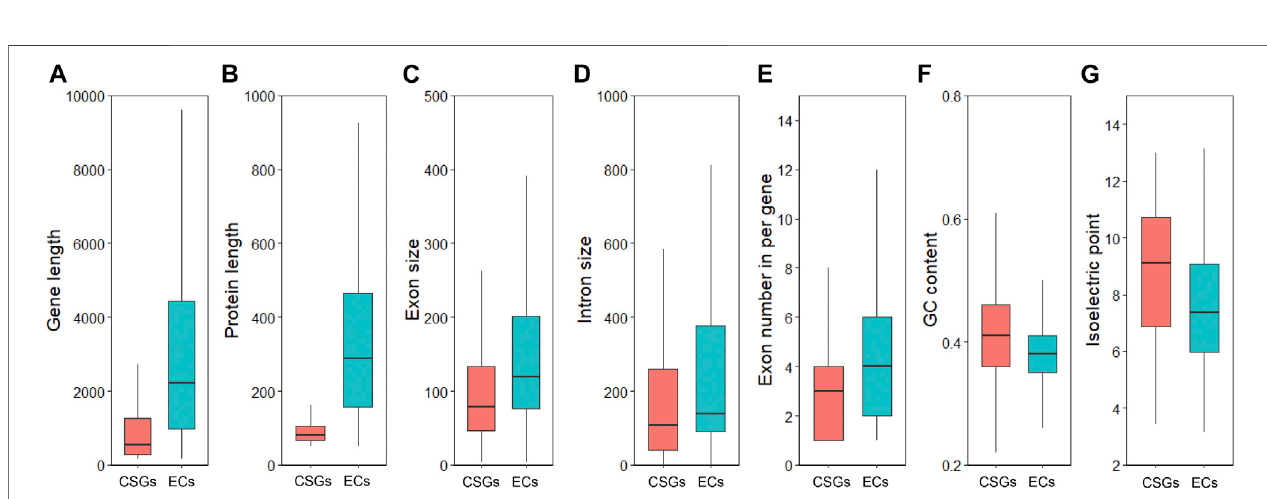
FIGURE 3 | Analyze and compare the structural characteristics of Camellia -speci fi c genes (CSGs) and evolutionarily conserved genes (ECs). (A) Box-plot comparisons of gene length. (B) protein length. (C) exon size. (D) intron size. (E) exon number in per gene. (F) GCs content. (G) isoelectric point.